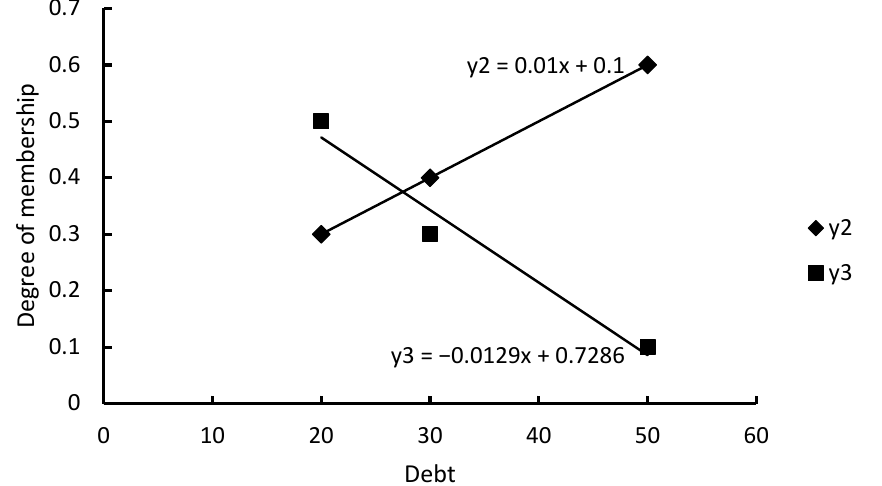
Figure A14. Single factor evaluation for the index of debt (20–50 (inclusive) ten thousand yuan).